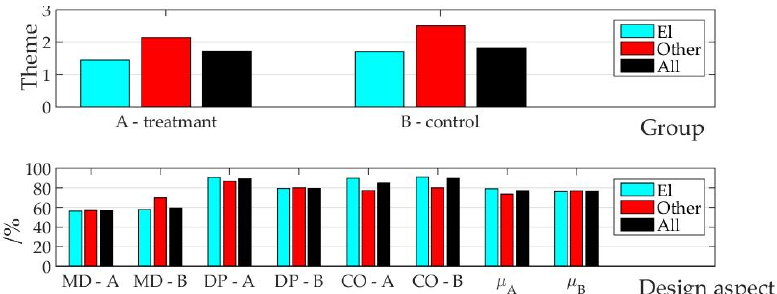
Figure 10. Final project test results: MD—modularity; DP—datapath; CO—Controller. MD, DP and CO are given in average percentages, whereas μ = the mean value of the MD, DP and CO sum.